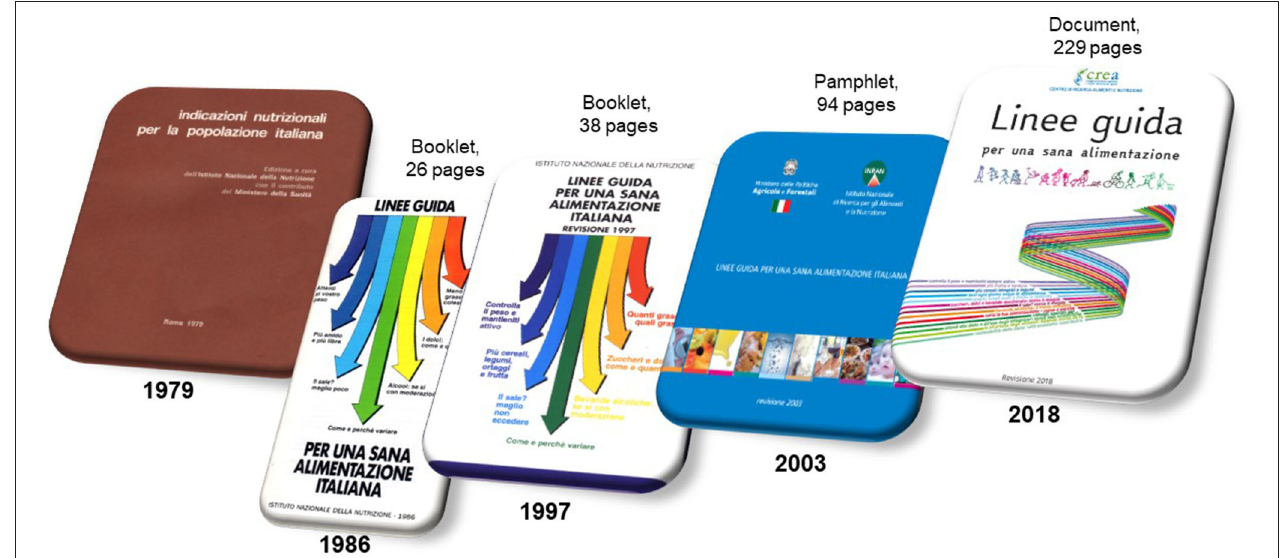
FIGURE 1 | History of Italian Dietary Guidelines